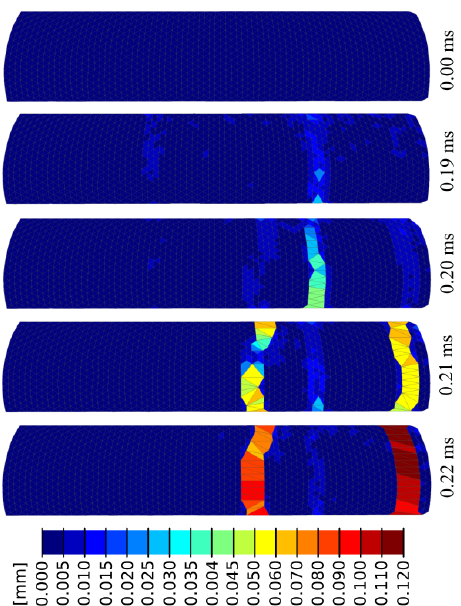
Figure 10. Crack detection. Visualization of || (cid:126)t rel, 2 D || for each triangle for some selected time steps at the begin of the crack opening.